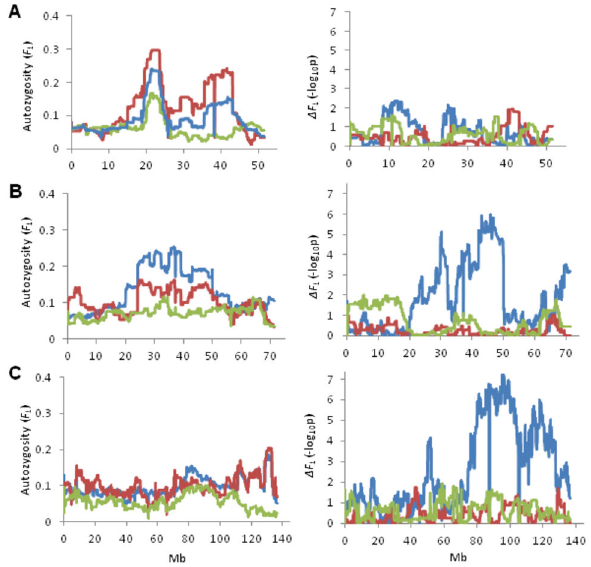
and ΔF across L L